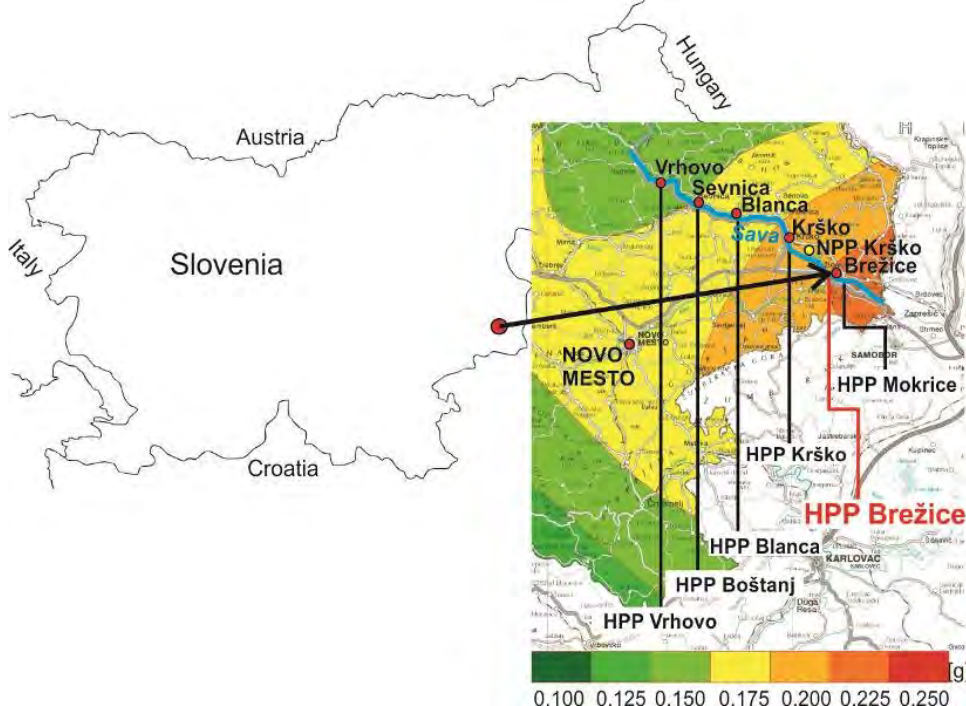
Figure 1. Location of the HPP